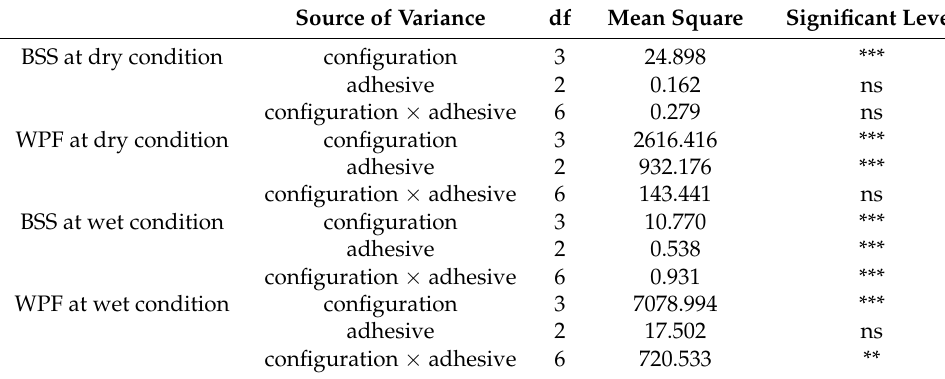
Figure 5. BSS and WFP of CLT and HCLT specimens at wet condition: ( a ) Influence of configuration, and ( b ) Influence of adhesive. Table 5. ANOVA results of BSS and